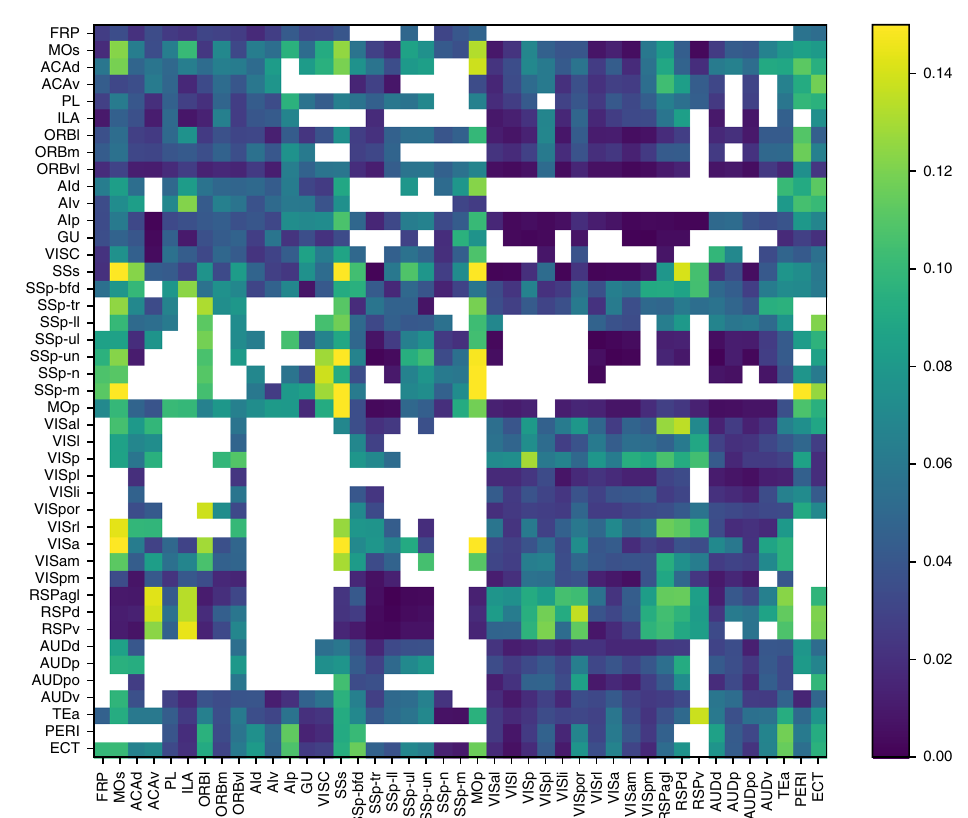
Fig. 4 Validation of predicted mapping. Relative error of the mapping de fi ned by the barycentric coordinate systems in the target area, compared with the data. Values along the main diagonal: for contralateral mapping; all others: ipsilateral mapping. The data shown where the sum of densities from all projection classes is above 0.025 μ m −